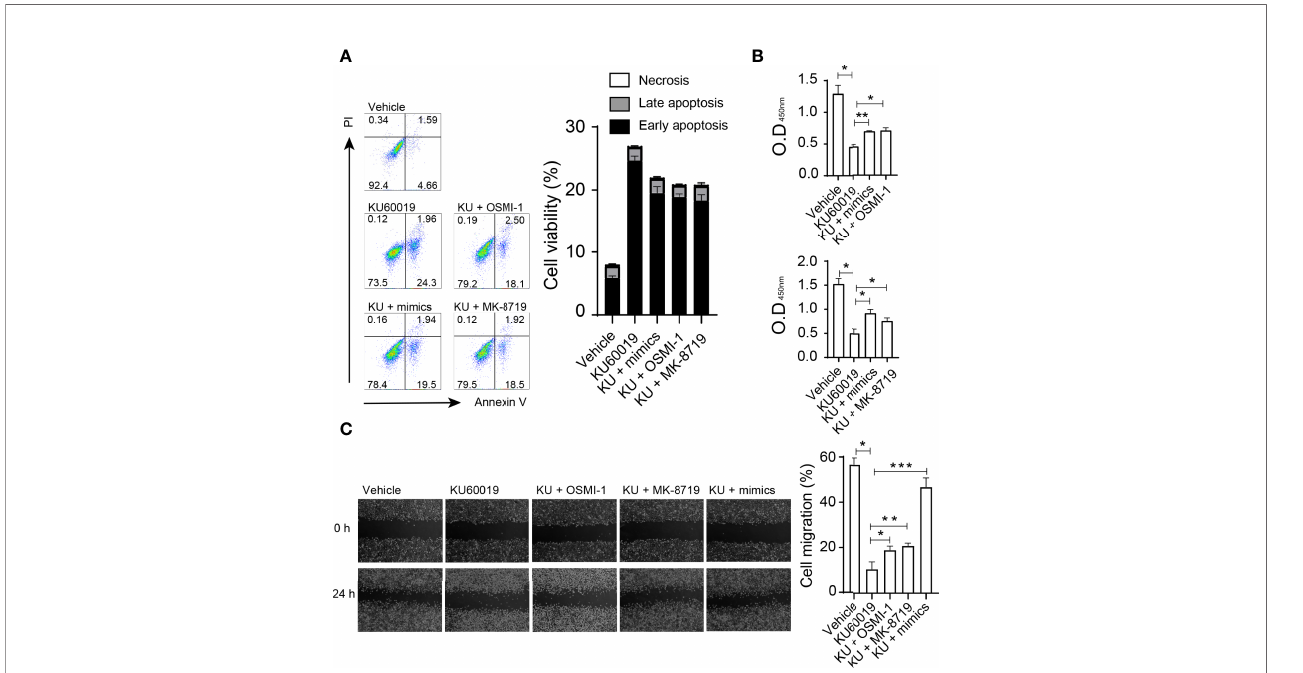
FIGURE 4 | SKOV3 cells were cultured in 6 well plates and transfected with miR-542-5p mimic, or treated with KU60019 (10 m M), or MK-8719 (10 m M), or OSMI-1 (20 m M) for 24 h prior to wounding or apoptosis detection. Then cells were collected and stained with indicated reagents for apoptosis detection. SKOV3 cell apoptosis was examined by annexin V/PI staining (A) . (B) Detection of cell growth by CCK-8 assay. Images were taken of each well at indicating time-points. The width of the wound was measured three times per image (C) . *P< 0.05;**P< 0.01; ***P<0.001. Data are representative of three independent experiments with similar results. Quanti fi cation of signal was shown in bar graphs and error bars represent mean ± SD.